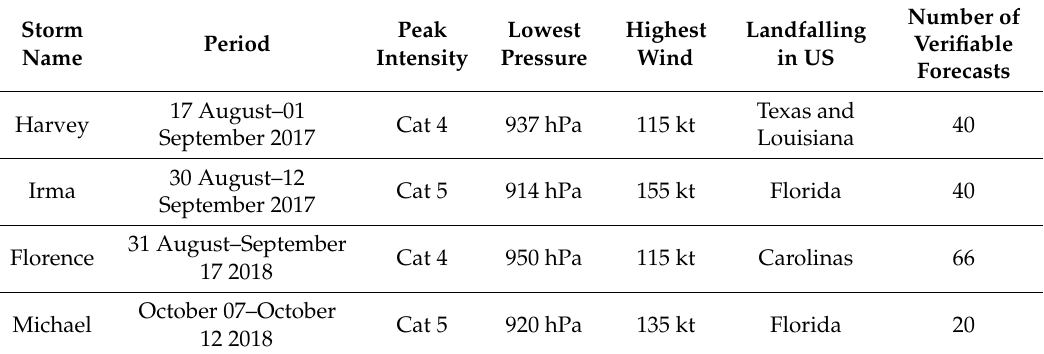
Table 1. Summary of the selected hurricane cases in this study. More detailed information is available in the National Oceanic and Atmospheric Administration (NOAA) NHC’s Tropical Cyclone Reports. Intensity categories for hurricanes are listed according to the Sa ffi r–Simpson scale. Cat indicates category. The kt indicates knot, which is a unit of speed equal to one nautical mile per hour (approximately 1.15 mph or 1.85 km /